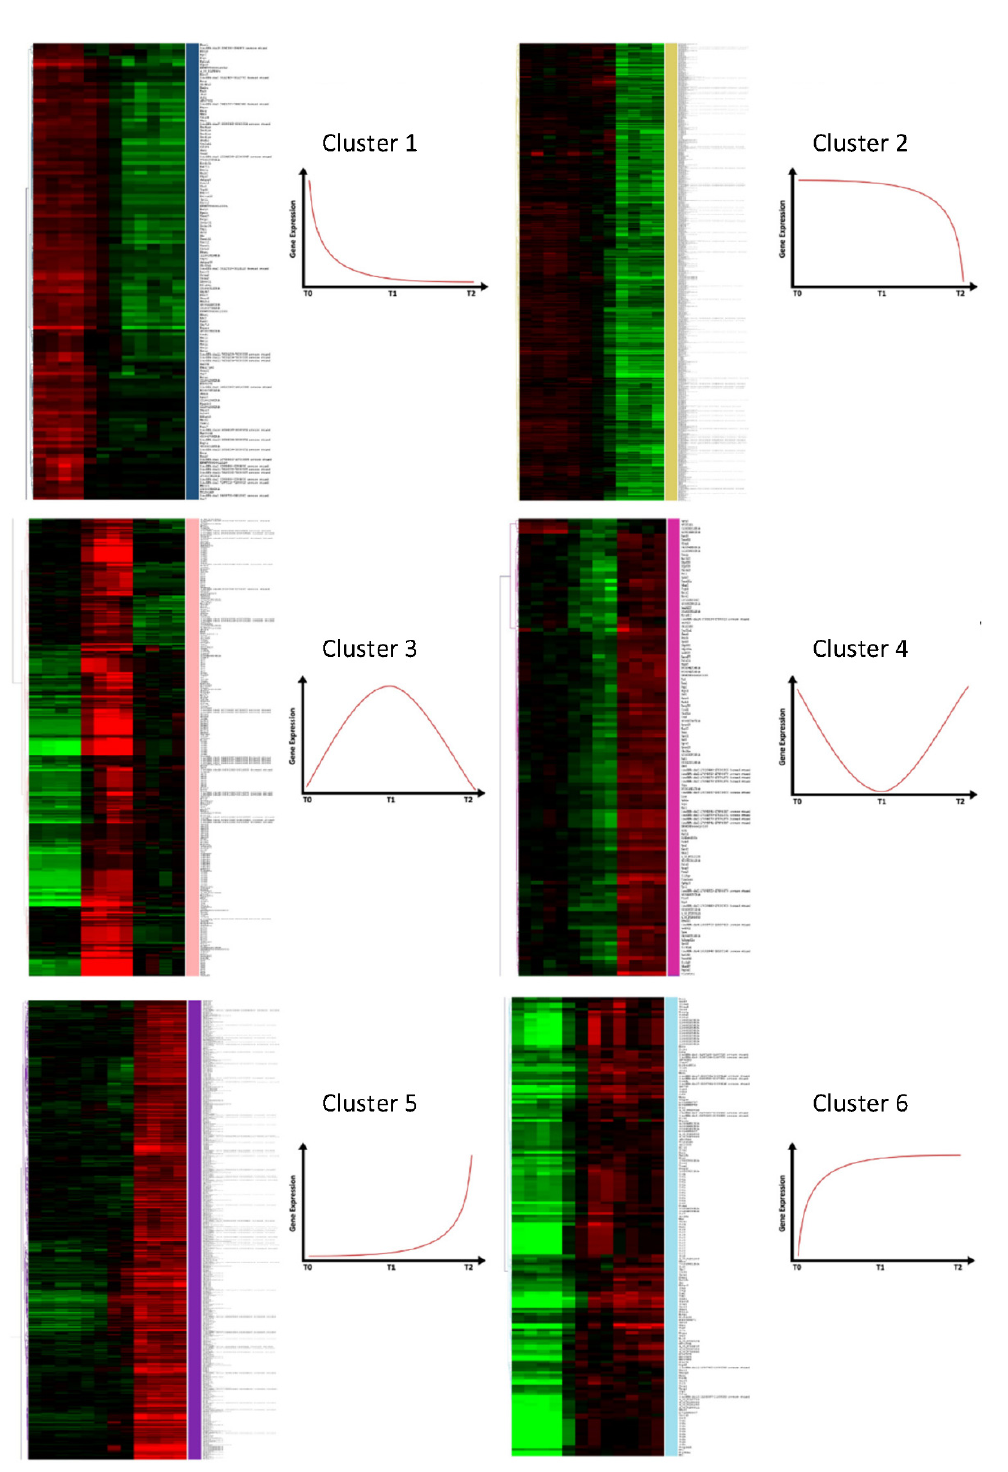
Figure 3. Hierarchical clustering of probes and schematic gene expression profile for each cluster identified in our mouse sepsis model (blue, yellow, light pink, fuchsia, purple, and light blue). A gene's expression profile corresponding to each heatmap cluster is shown to its right.